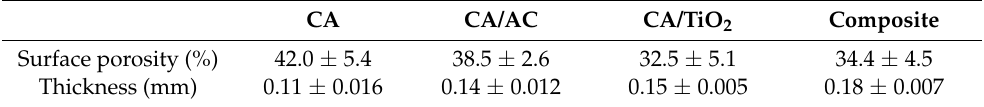
Table 2. Results from the analysis of the filter porosity and thickness.